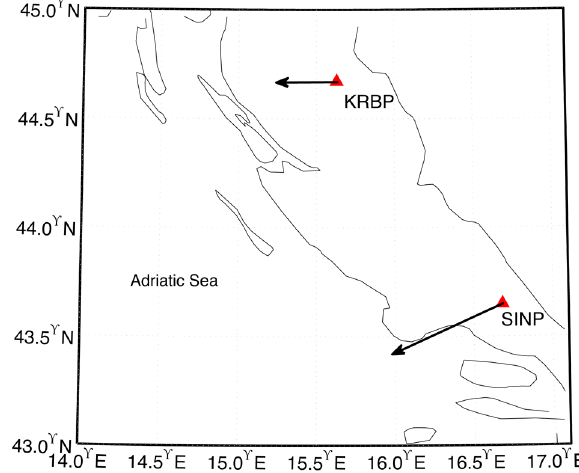
Figure 4. Real induction arrows at period T = 18.3 min for KRBP (amplitude of 0.24) and SINP (amplitude of 0.50), with respect to the reference point